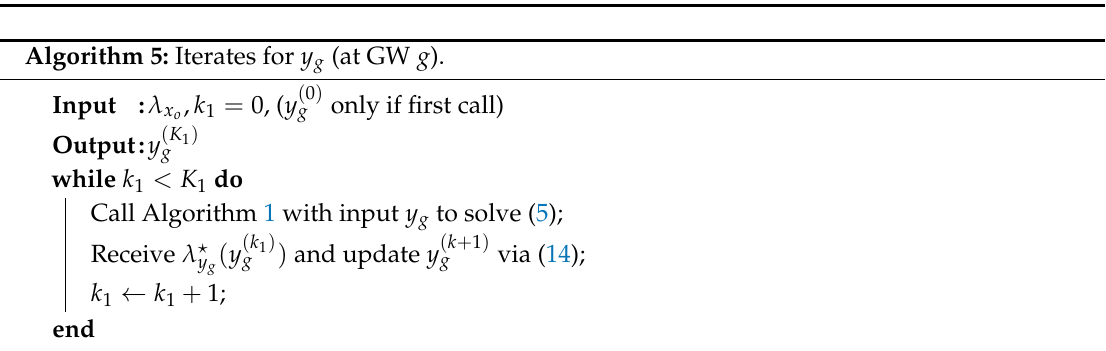
Algorithm 5: Iterates for y g (at GW g